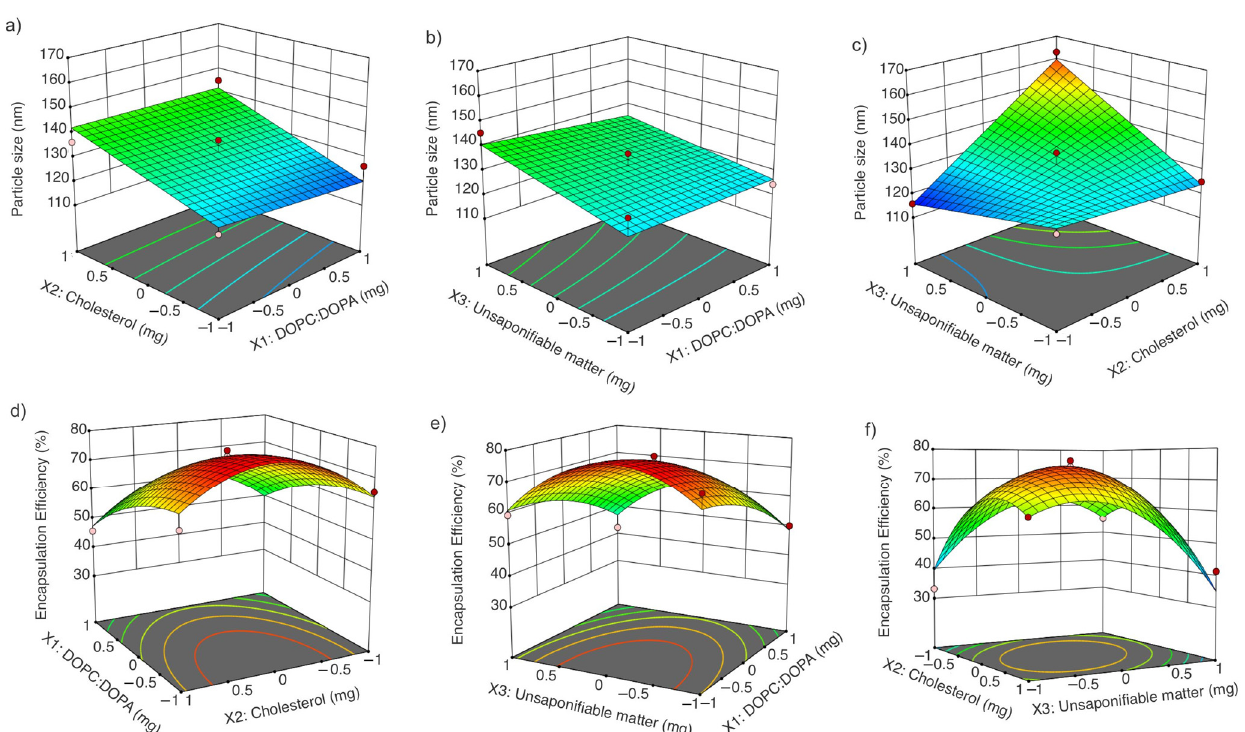
Figure 3. Response surfaces and contours: ( a ) X 2 and X 1 interaction in particle size response; ( b ) X 3 and X 1 interaction in particle size response; ( c ) X 3 and X 2 interaction in particle size response; ( d ) X 1 and X 2 interaction in encapsulation efficiency response; ( e ) X 3 and X 1 interaction in encapsulation efficiency response; ( f ) X 2 and X 3 interaction in encapsulation efficiency response.